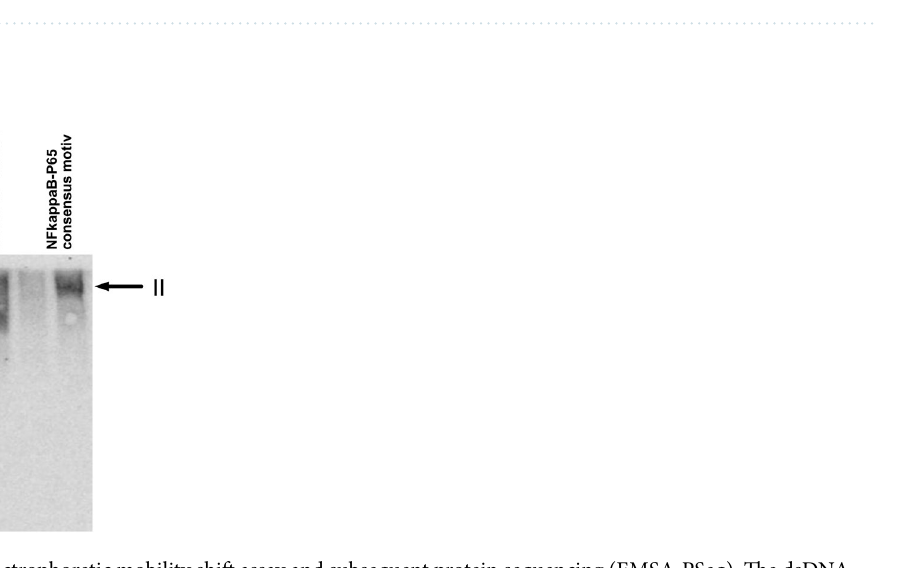
Figure 2. No. of predicted interaction partners unique to the six-marker-haplotype observed among concordant and discordant CF sibling pairs. Using the software Match at http://www.gene-regul ation .com/ 14 , binding sites for transcription factors were predicted for the two contrasting haplotypes composed of the six SNPs rs152730–rs152731–rs152745–rs152744–rs152741–rs152740. The figure shows the number of additional, allele-specific transcription factor binding sites predicted on the haplotype associated with intrapair concordance (grey) and for intrapair discordance (red). Please note that six allele-specific binding sites were predicted for haplotype GCA GTT while for TTG ACA , associated with discordance, a total of 21 additional binding sites for transcription factors are predicted. Binding sites predicted to be shared for both alleles are not shown.